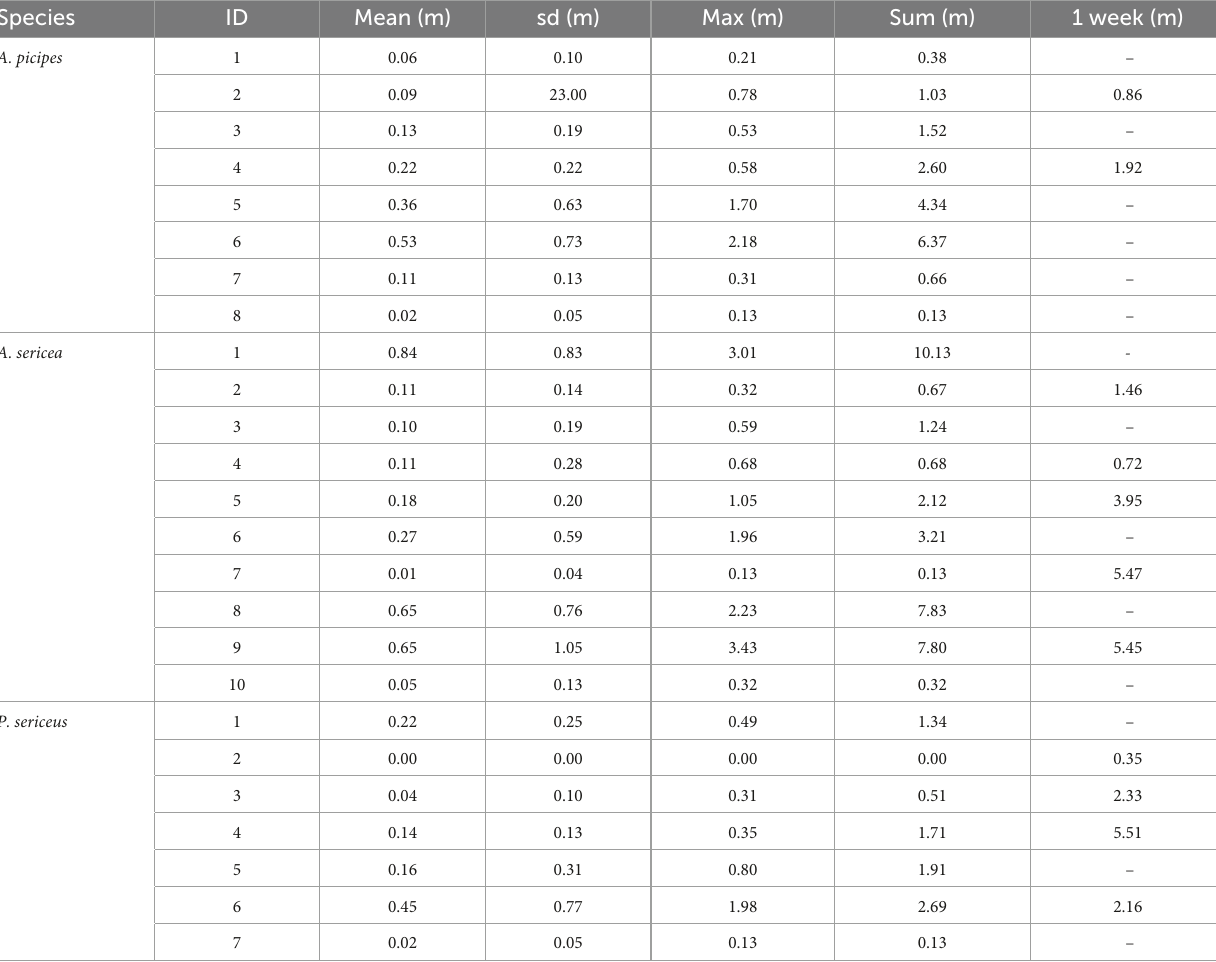
TABLE 2 Movements of the three species in the field. Species ID Mean